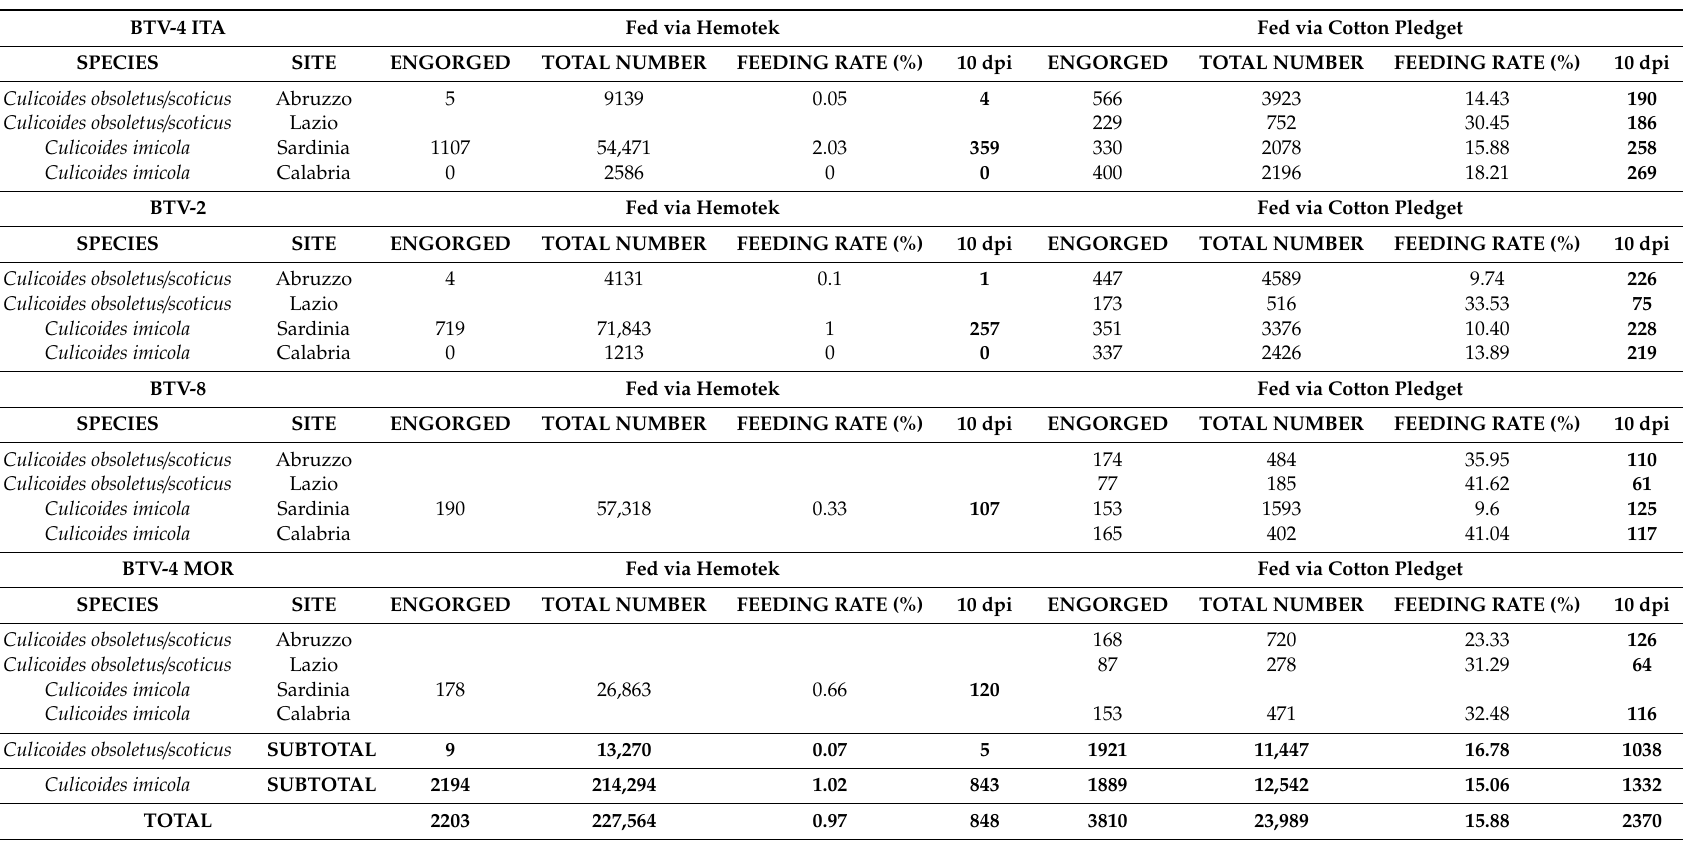
Table 1. Feeding rate and number of surviving midges at 10 days post-infection (dpi) according to strain, feeding method, and population. BTV-4 ITA Fed via